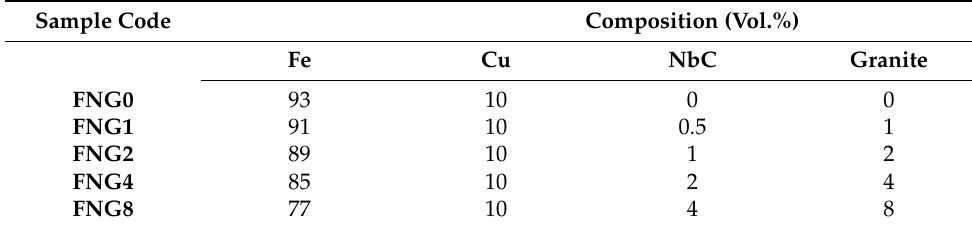
Table 3. Batch design of the prepared